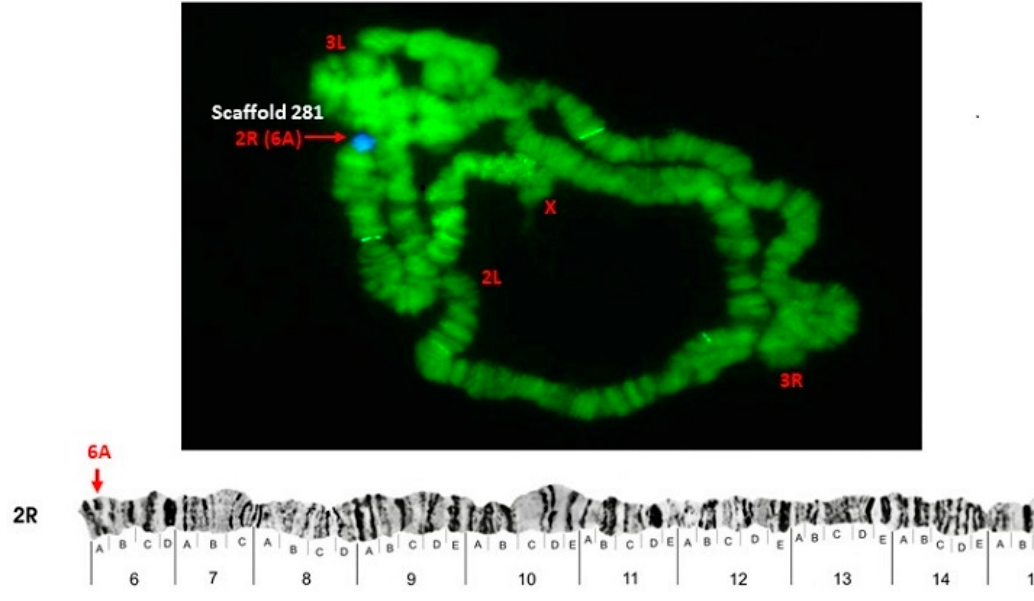
Figure 3. Pb7b-Cy 5 probe, mapped in the 6A band in 2R of A. darlingi , as shown by arrows. Chromosomal bands with positive hybridization are identified with text in red, and the corresponding scaffolds in An. darlingi genome assembly AdarC3 are indicated in white text.